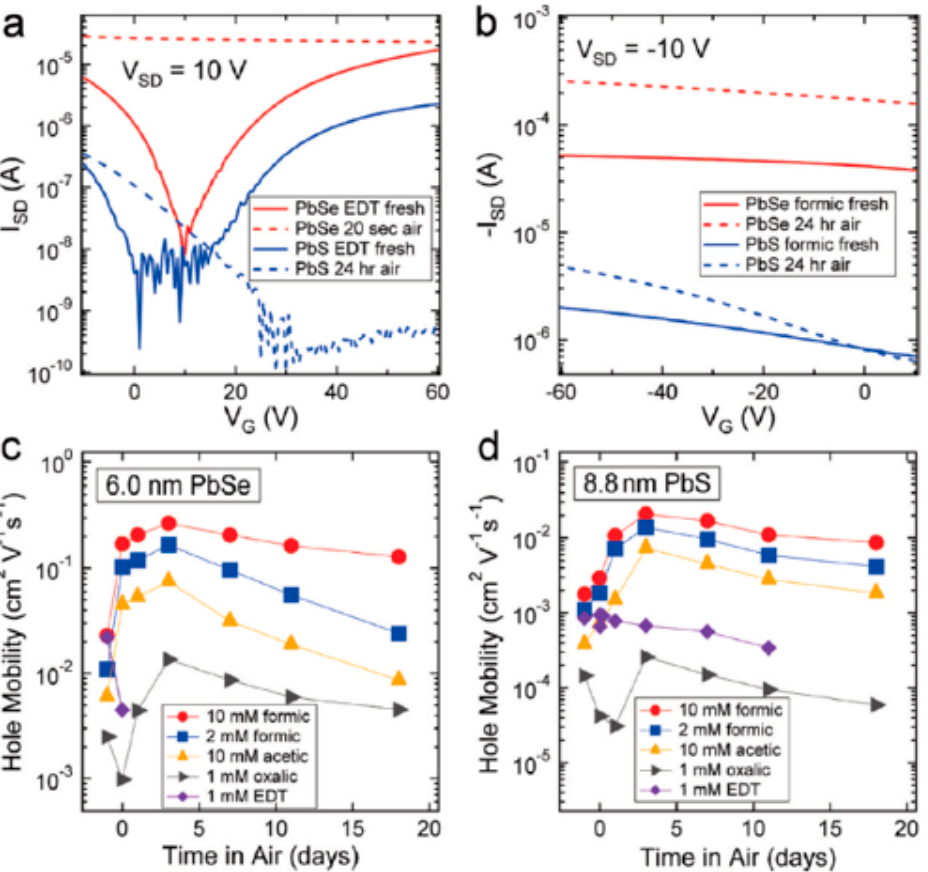
Figure 3. Electrical performance of PbSe and PbS QD field-effect transistors (FETs) according to air exposure. ( a ) Transfer curves (I D -V G ) of ethanedithiol (EDT)-treated PbSe and PbS FETs. ( b ) Transfer curves of formic-treated PbSe and PbS FETs. ( c ) Hole mobility changes over time of carboxylate-capped PbSe FETs in air. ( d ) Hole mobility changes over time of carboxylate-capped PbS FETs in air. Reprinted from reference [20]. Copyright 2010 American Chemical Society.